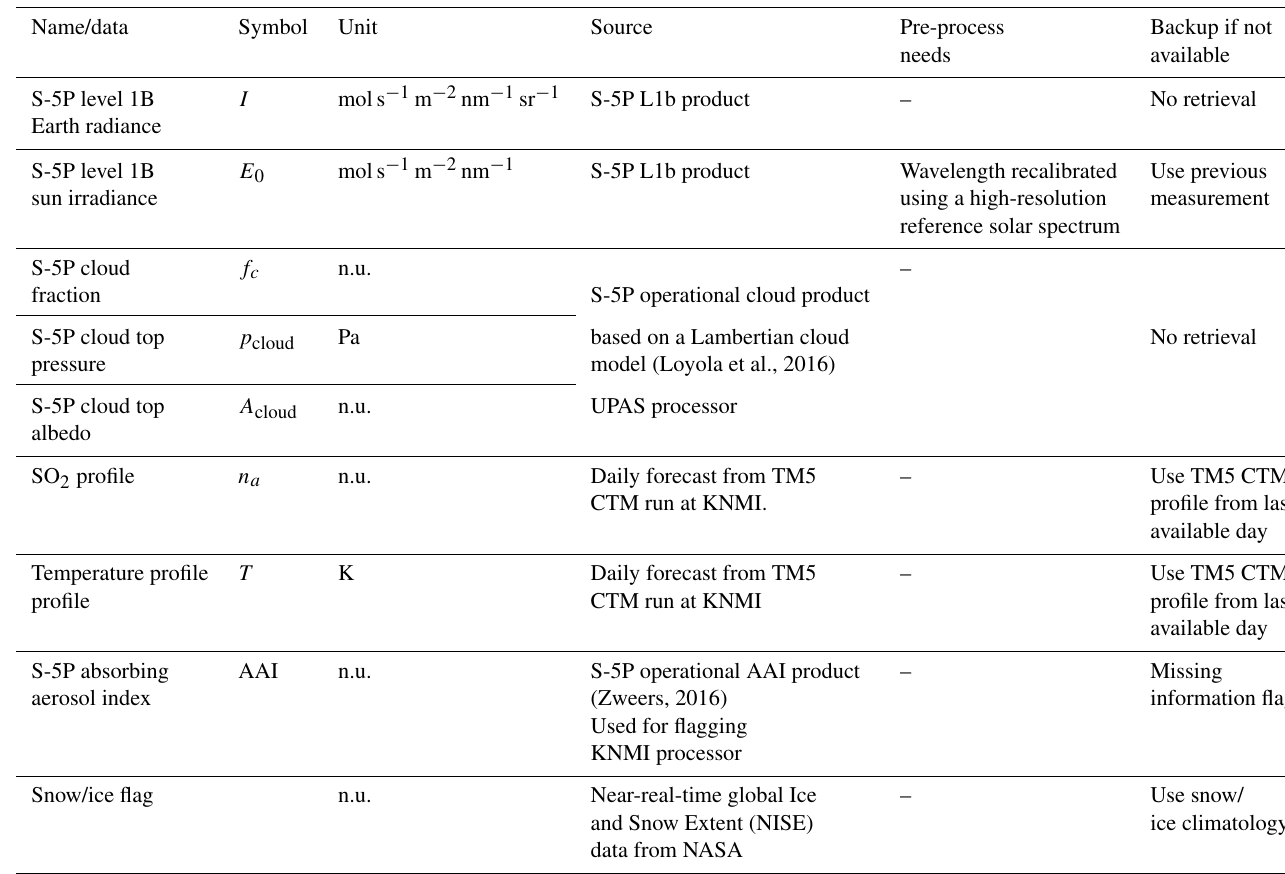
Table A3. Dynamic auxiliary data for the S-5P SO 2